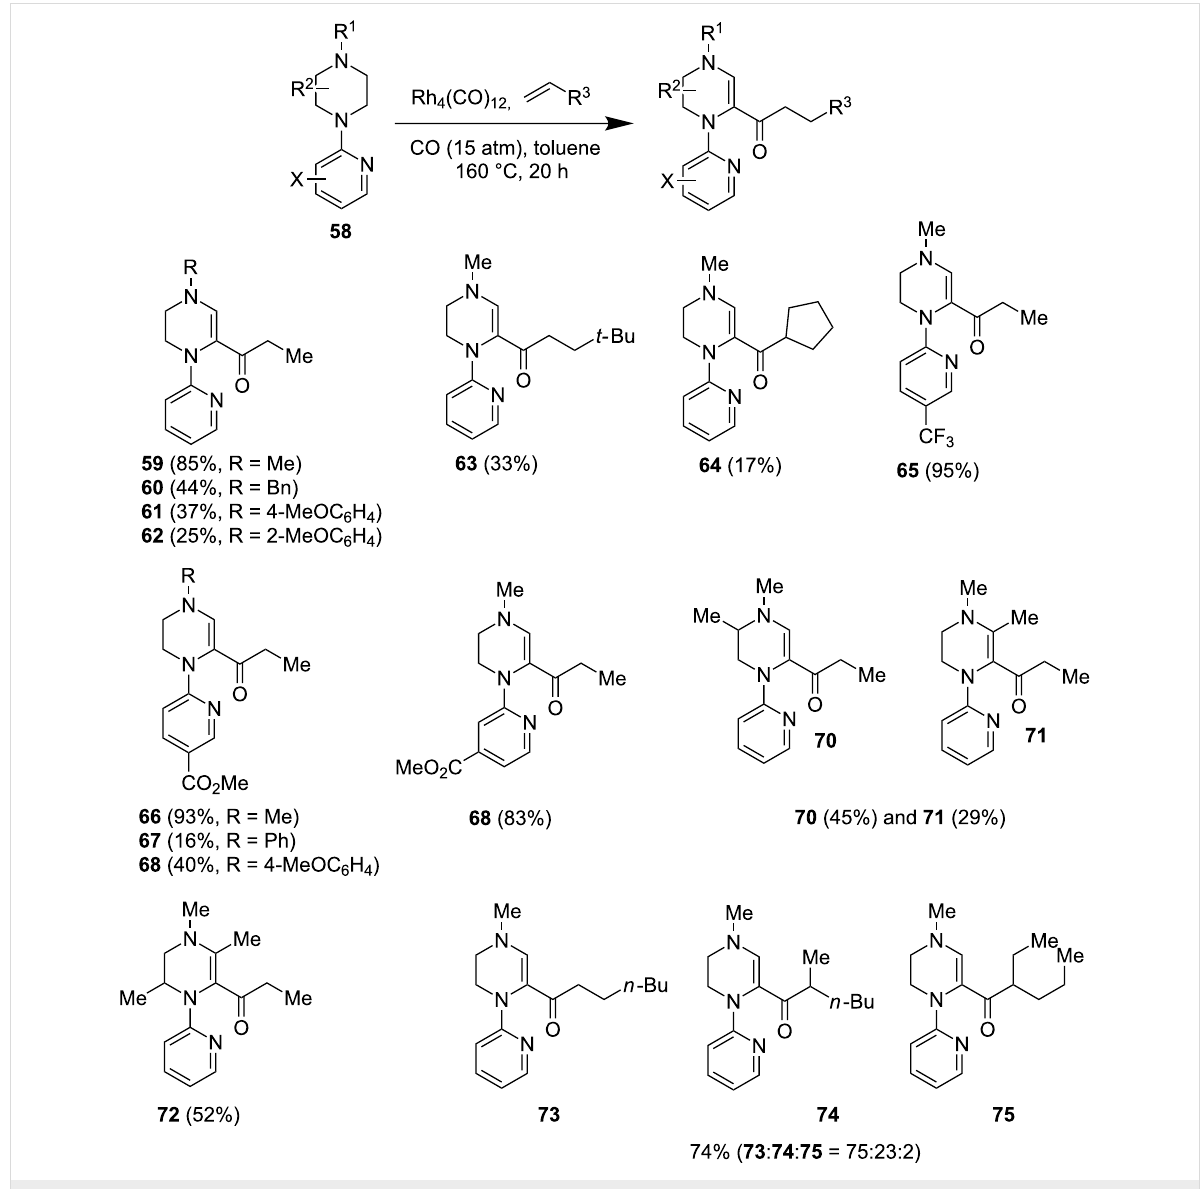
Figure 13: Rh-catalyzed reactions of N -(2-pyridinyl)piperazines by Murai et al. in 1997